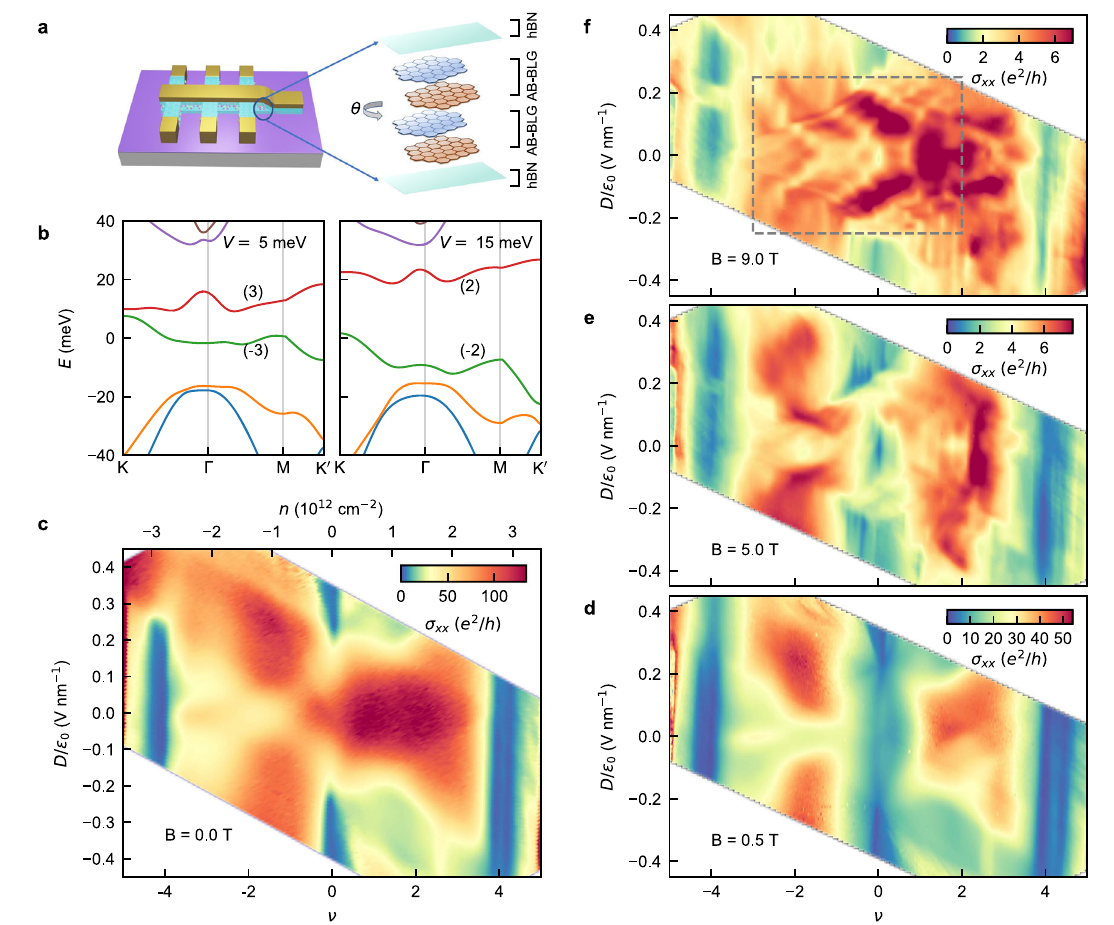
Fig. 1 | Magneto-transport in twisted double bilayer graphene (TDBG). a Schematic ofthe dual gated TDBGdevice. b Calculated band structure for TDBG withtwistangle1.10 ∘ inabsenceofthemagnetic fi eldfortwodifferentvaluesofthe interlayer potential V . Interlayer potential simulates the application of the electric fi eld. The numbers in brackets adjacent to each band indicate the corresponding